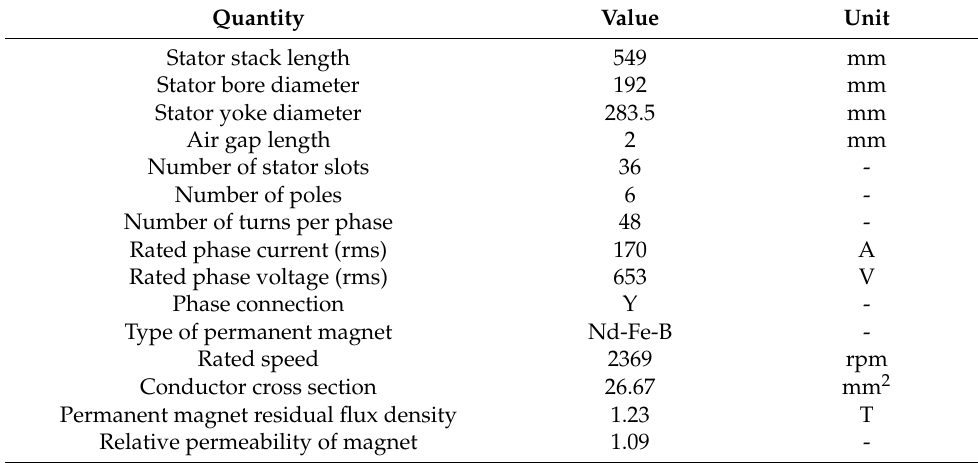
Table 2. Stator specification of the studied